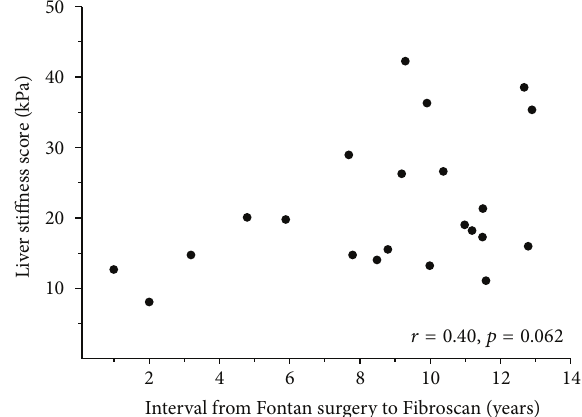
Figure 2: Transient elastography results versus time interval since